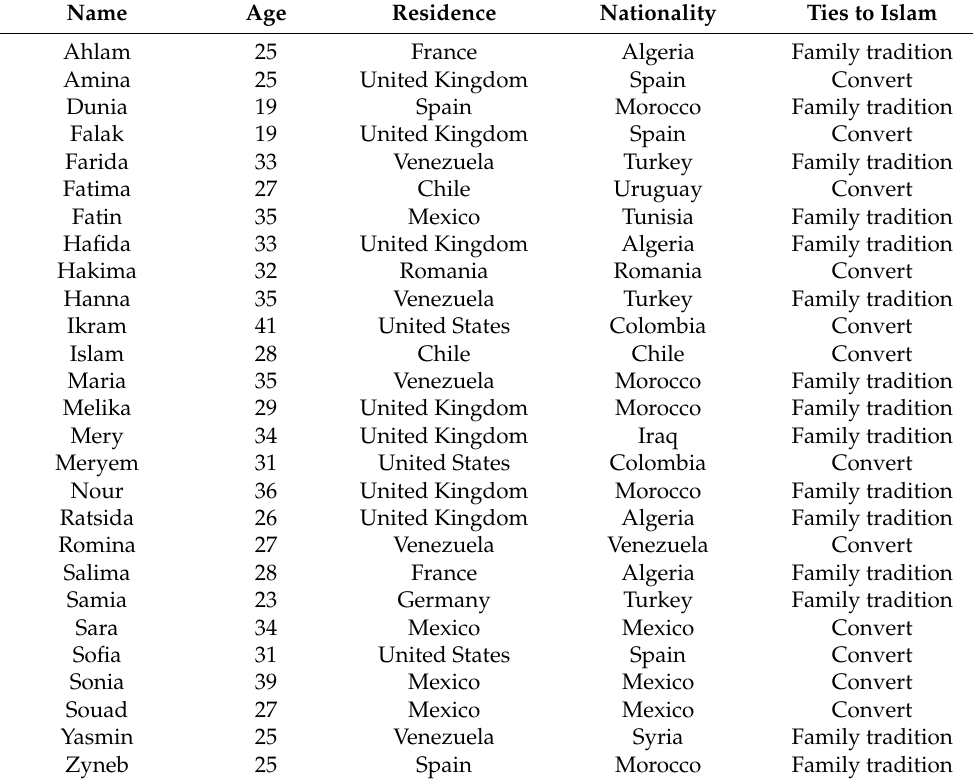
Table 1. Profiles of the niqabi women which were